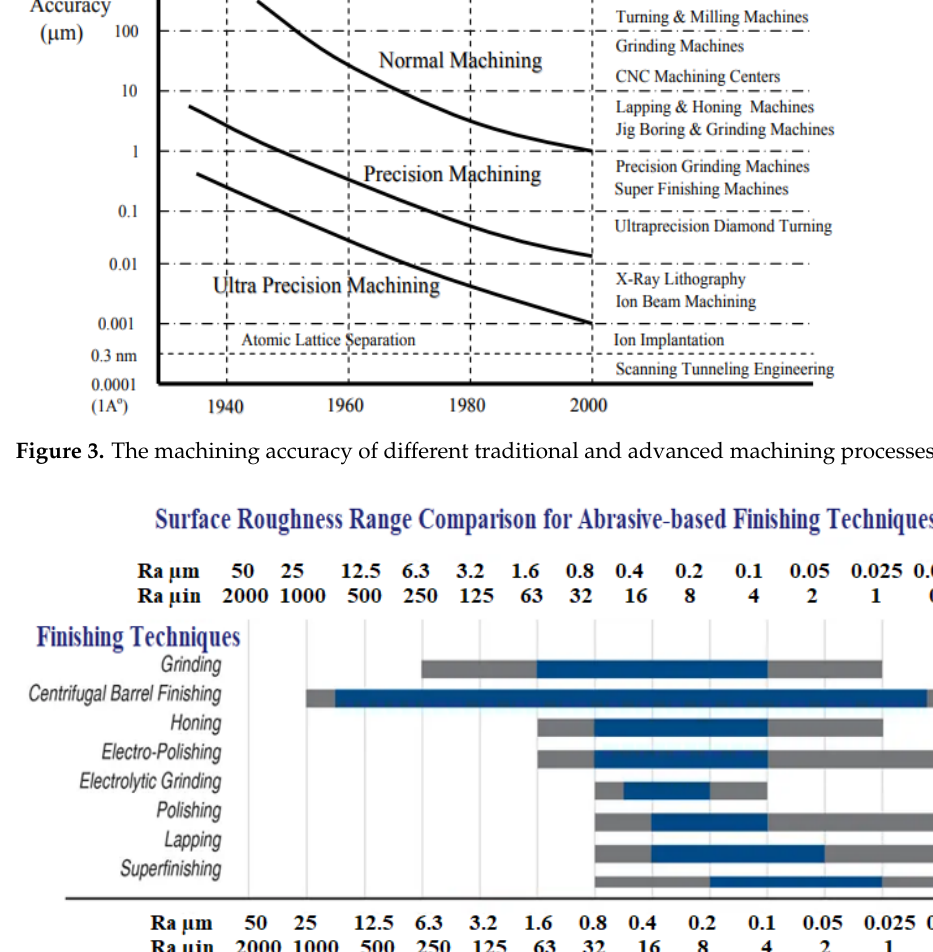
Figure 2. Categories of Loose Abrasive-Based Machining Process. The machining accuracy of different traditional and advanced machining processes is described in Figure 3.